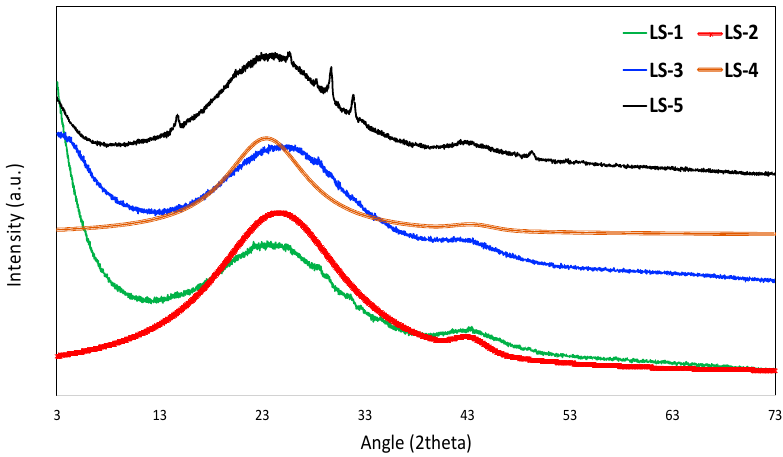
Figure 5. X-ray diffraction (XRD) results.